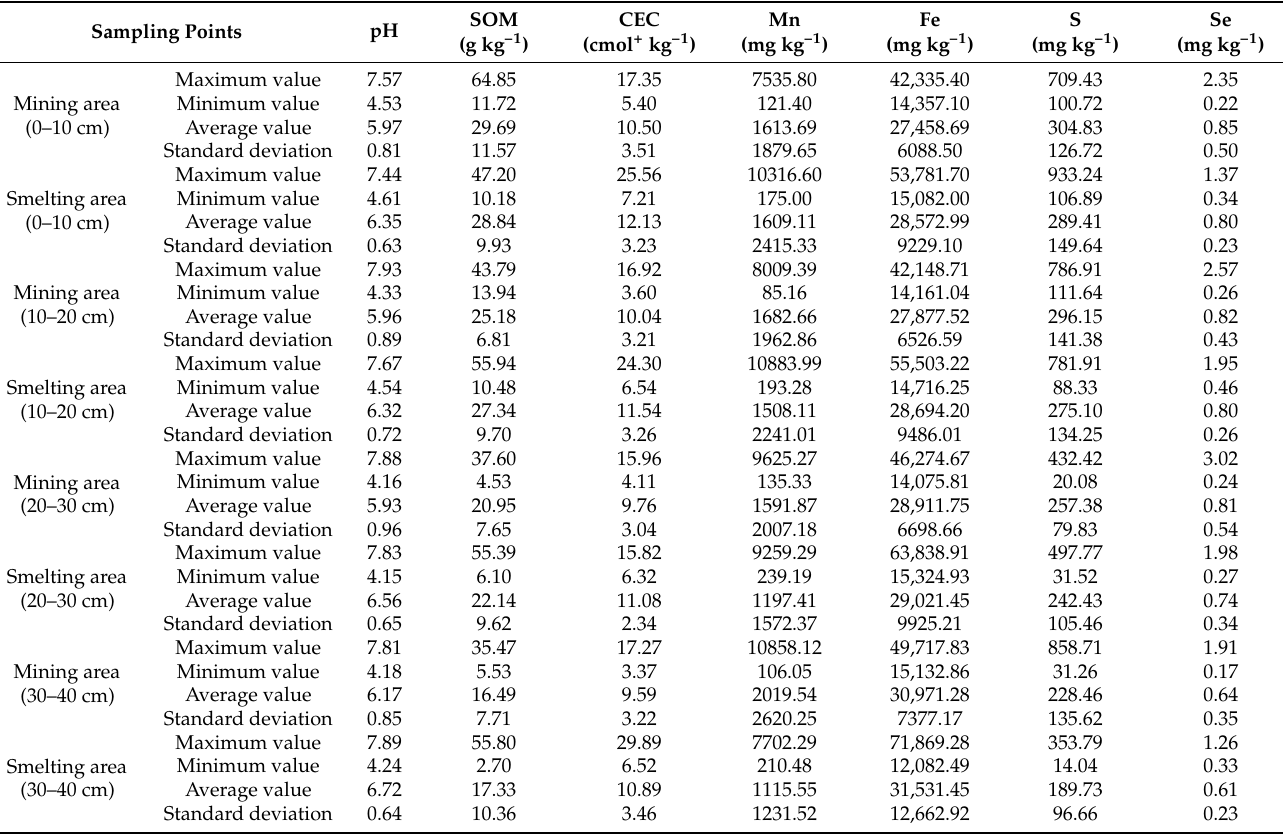
Table 2. Properties and components in soils of different profiles in the manganese mining and smelting